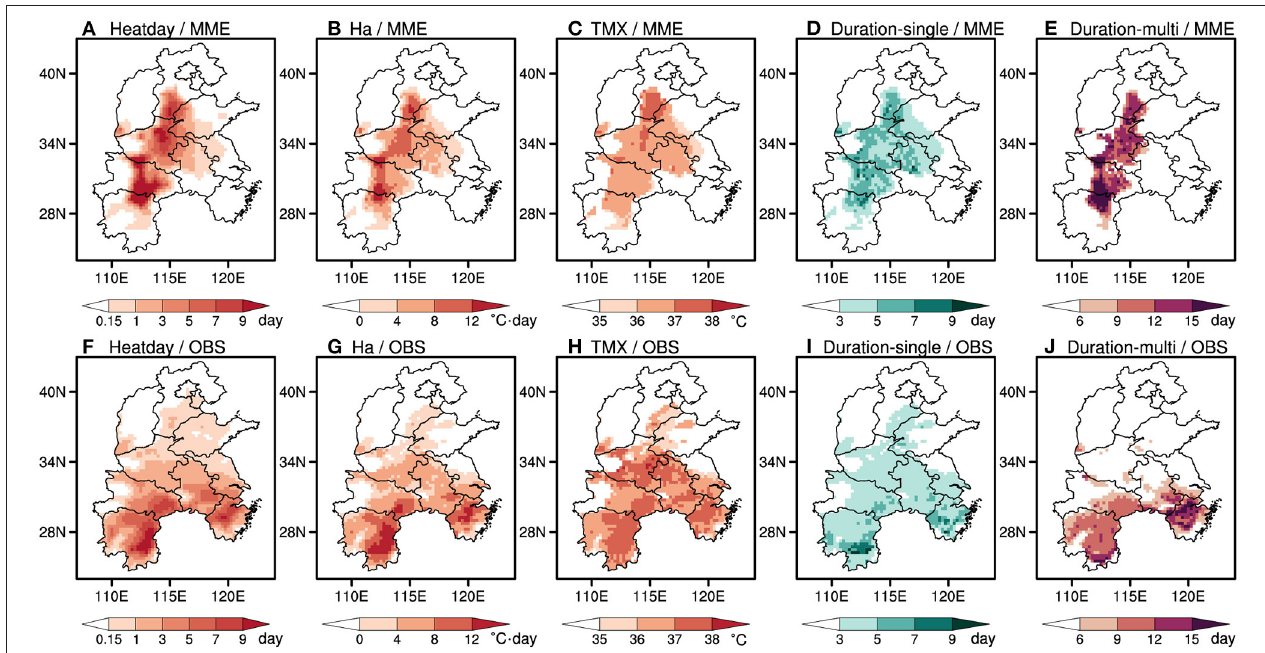
FIGURE 2 | Spatial distributions of observed and multimodel averaged heat damage indexes in Central and East China during 1986–2005. (A,F) The number of high-temperature days (unit: day), (B,G) hazardous heat accumulation temperature (unit: ◦ C · day), (C,H) maximum temperature in the process of heat damage (unit: ◦ C), (D,I) single-process duration of heat damage (unit: day), and (E,J) multiple-process duration of heat damage process (unit: day).